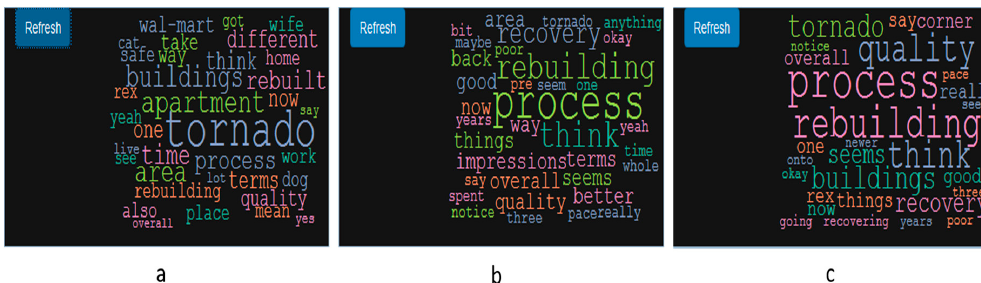
Figure 5. Wordcloud diagram for ( a ) an entire geonarrative ( b ) For the keyword ‘recover*’ ( c ) and then